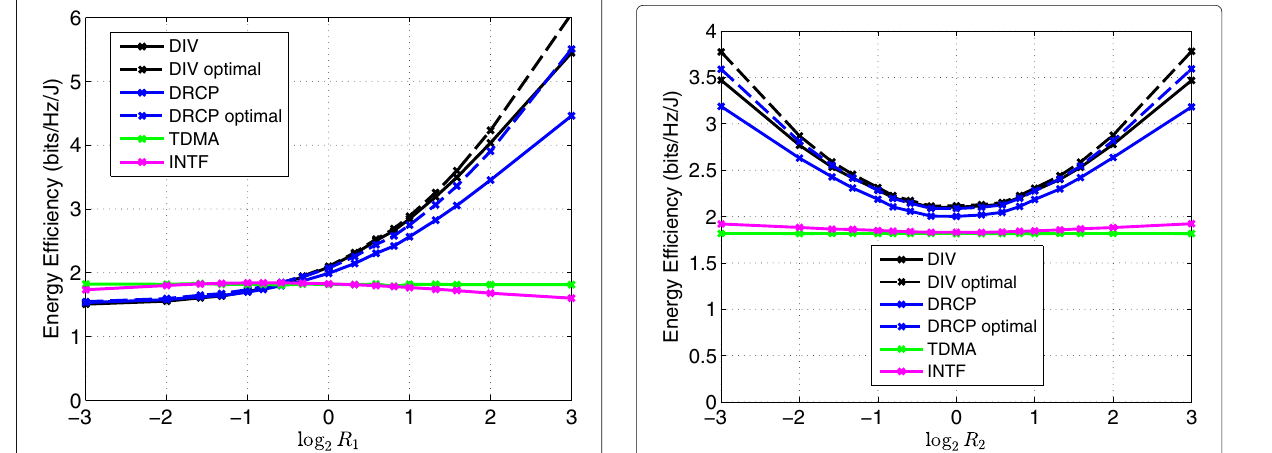
Fig. 4 Energy efficiency of the studied approaches in the transmit power-dominated regime with S min 1 = S min 1 = 0.3